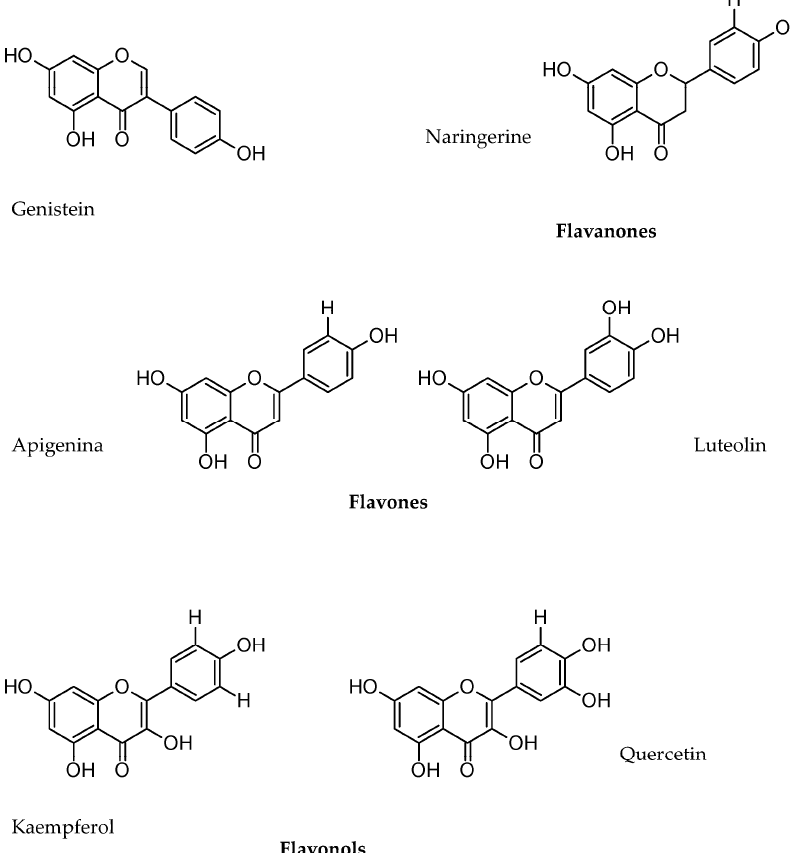
Figure 11. Genistein, flavones, flavonols, flavanones.